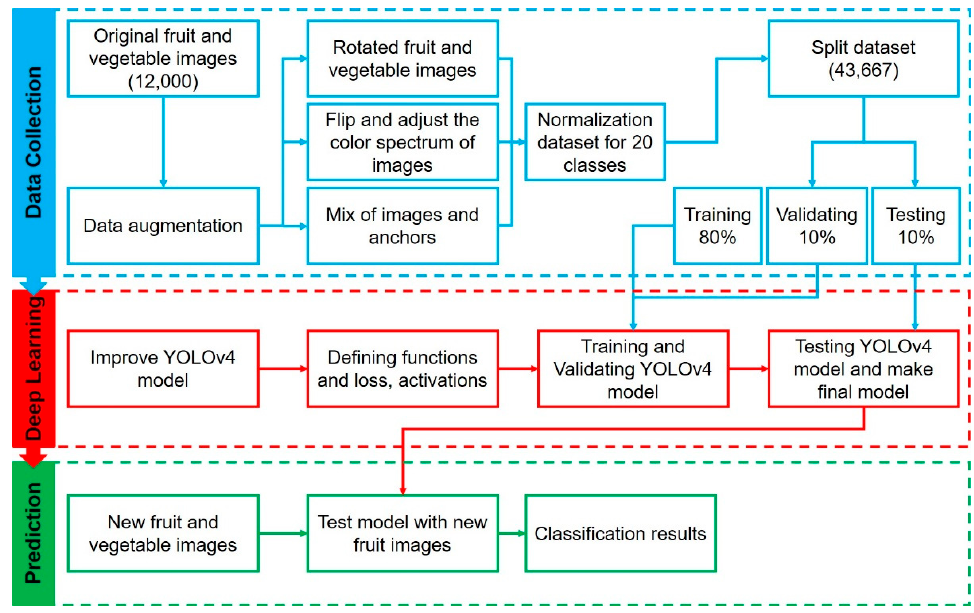
Figure 3. Modular representation of fruit and vegetable classification system.